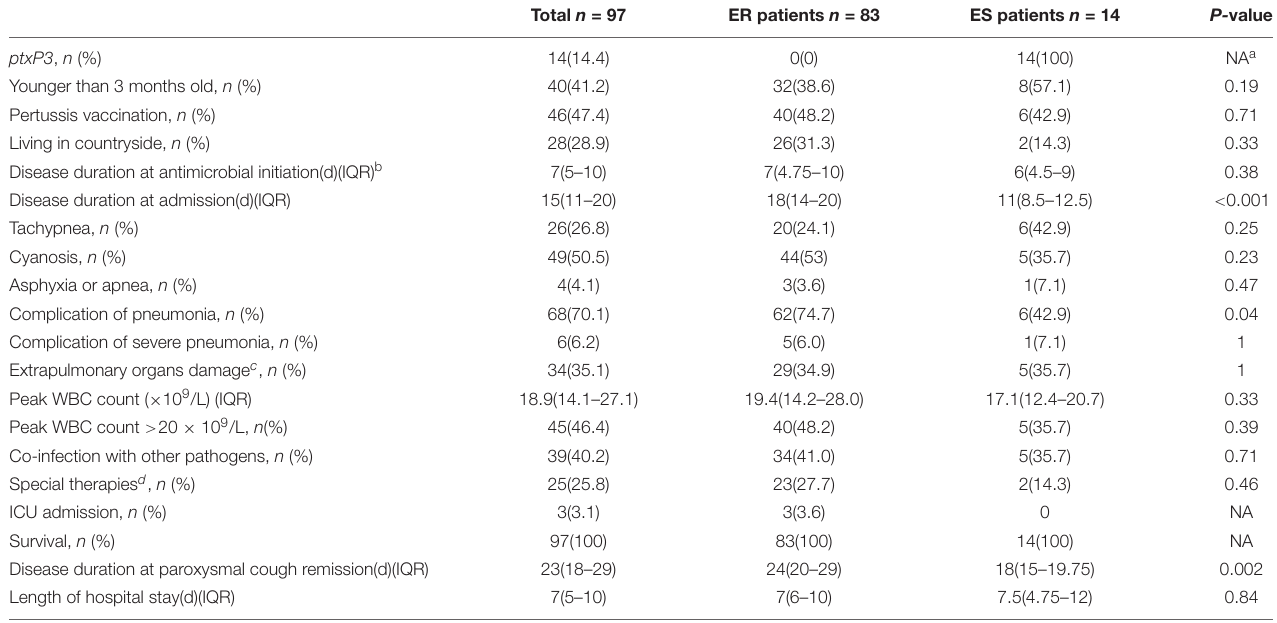
TABLE 2 | Clinical characteristics of the pertussis cases caused by erythromycin-resistant (ER) strains and cases caused by erythromycin-sensitive (ES) strains in China, 2017–2019. Total n = 97 ER patients n = 83 ES patients n = 14